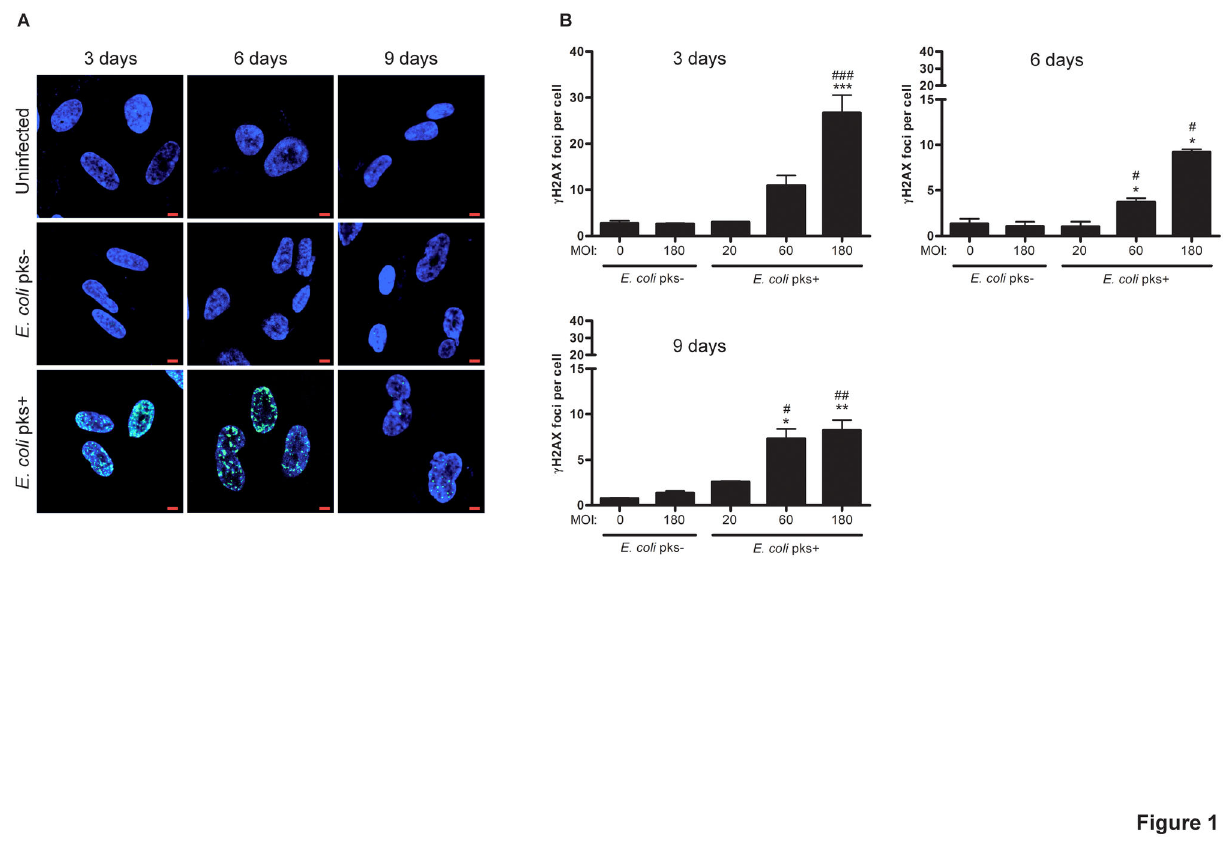
Figure 1. Persistent γH2AX foci in IMR-90 cells infected with pks + E. coli. Non-transformed human IMR-90 cells were infected for 4h with live pks + or pks - E . coli with a multiplicity of infection (MOI) of 20, 60 and 180 bacteria per cell or left uninfected. At the end of the infection, the cells were washed and further grown in medium supplemented with gentamicin. (A) Cells were examined for DNA (blue) and γH2AX (green) 3, 6 or 9 days after infection. Pictures of uninfected and MOI 180 -infected cells are shown, scale bars = 10µm. (B) The numbers of γH2AX foci per cell were quantified by a blinded observer in 30-100 nuclei for each condition in two independent experiments. Results represent the mean and standard error of the mean (SEM). Statistical significance was examined by one-way ANOVA with Bonferroni’s multiple comparison test; *P<0.05, **P<0.01, ***P<0.001 comparing infected and uninfected groups; #P<0.05, # #P<0.01, # # #P<0.001 comparing pks + and pks - groups. doi: